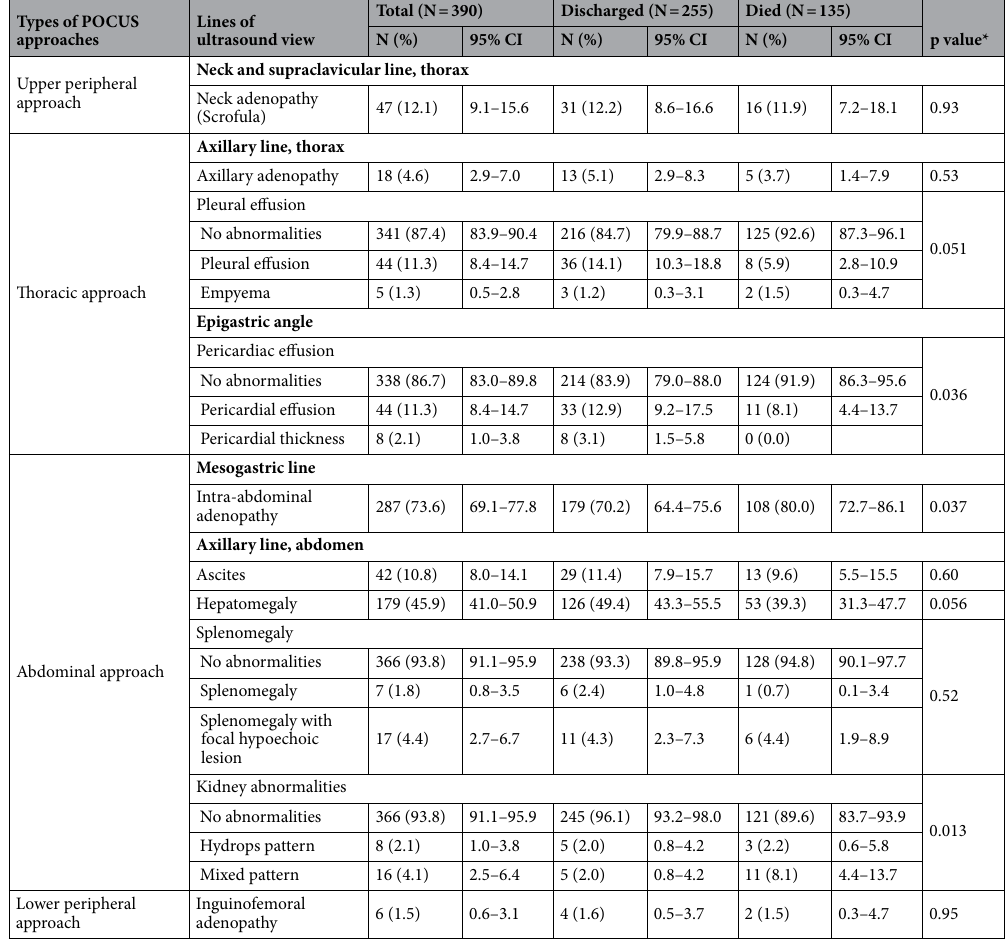
Table 2. POCUS findings in 390 in-patients with extrapulmonary tuberculosis enrolled at Hospital Carmelo de Chokwe (2016–2020), by mortality outcome. *Pearson